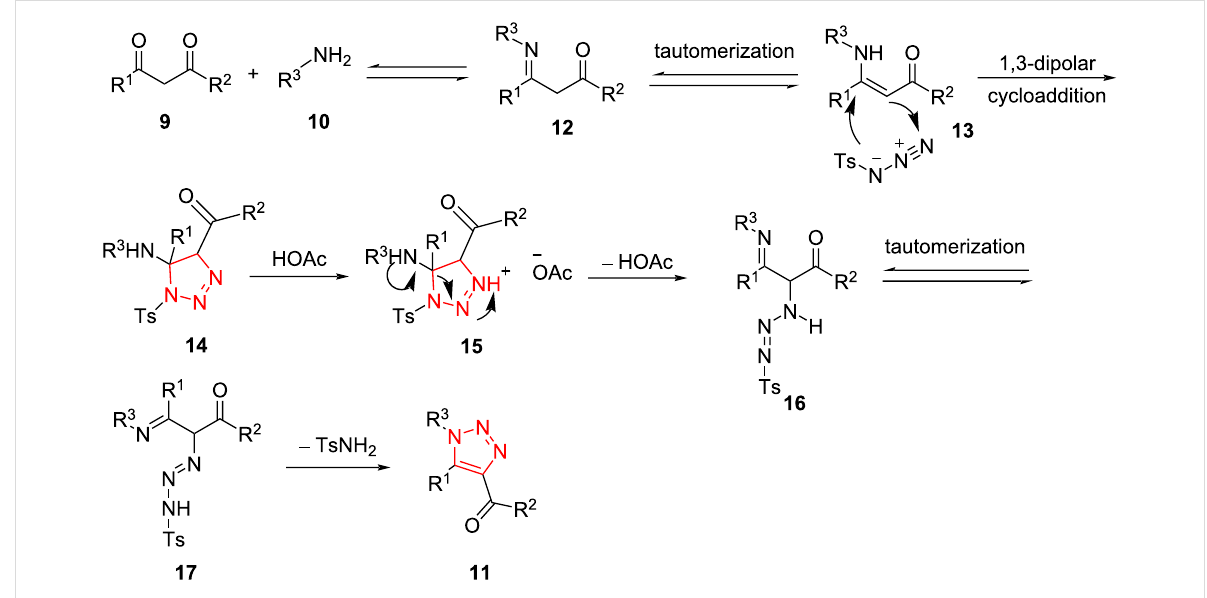
Scheme 7: The proposed mechanism for the synthesis of 1,4,5-trisubstituted 1,2,3-triazoles 11 from the reaction of primary amines 10 with 1,3-dicar- bonyl compounds 9 .